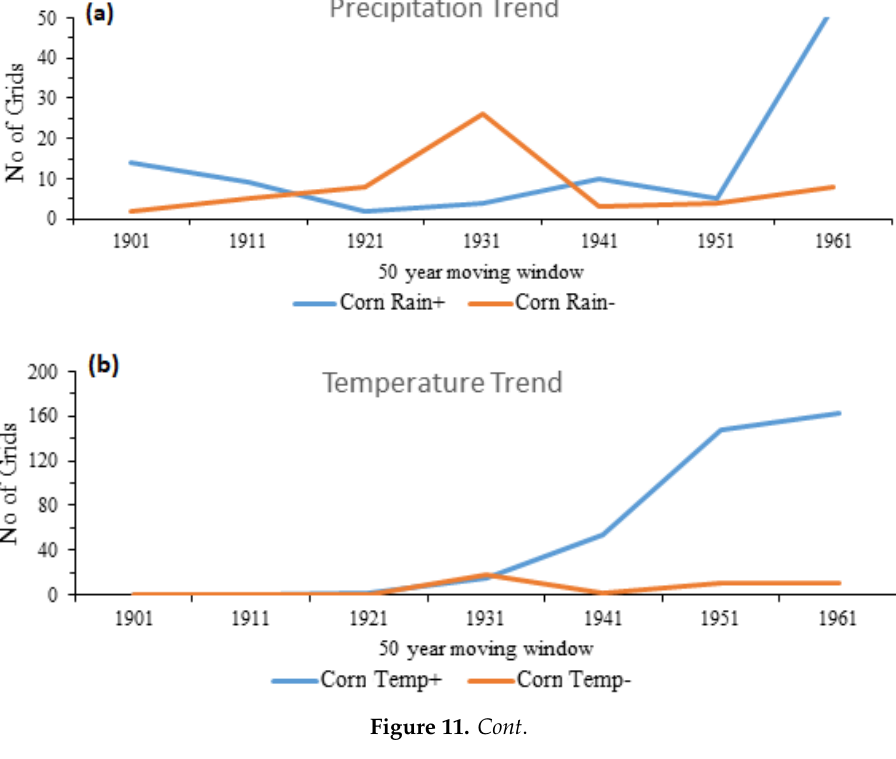
Figure 10 . Geographical distributions of the changes in ( a ) precipitation, ( b ) mean temperature, and ( c ) SPEI during corn-growing season in Afghanistan during 1901–2010.